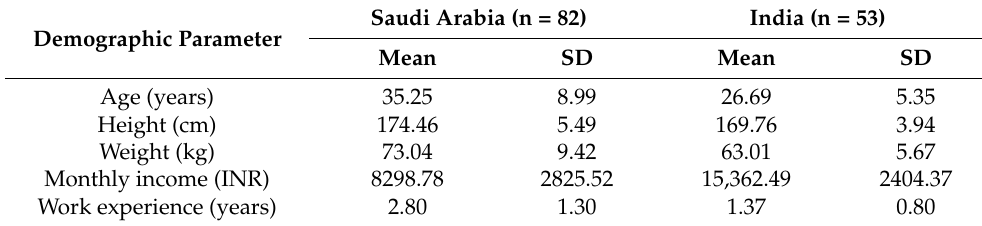
Table 2. Summary of socio-demographic features of the workers. Demographic